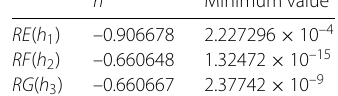
Table 3 The minimum values of RE ( h ∗